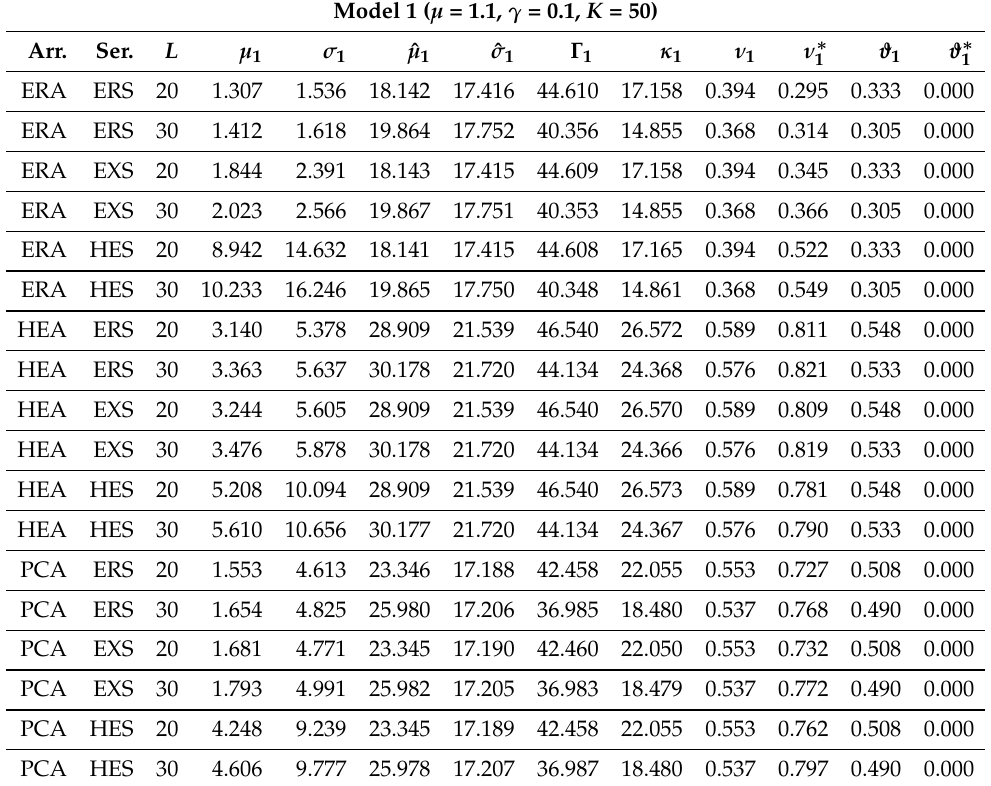
Table 3. Comparing Model 1 and Model